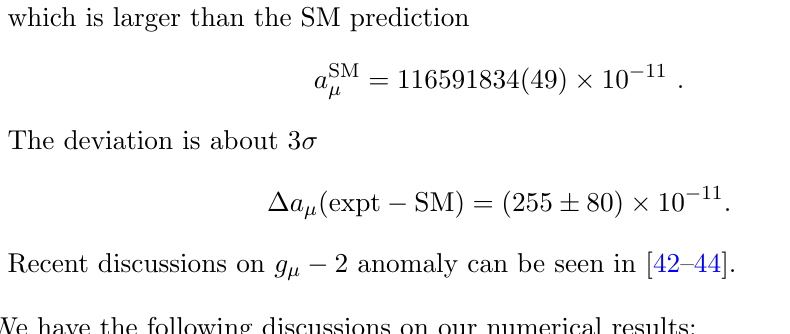
JHEP08(2017)089